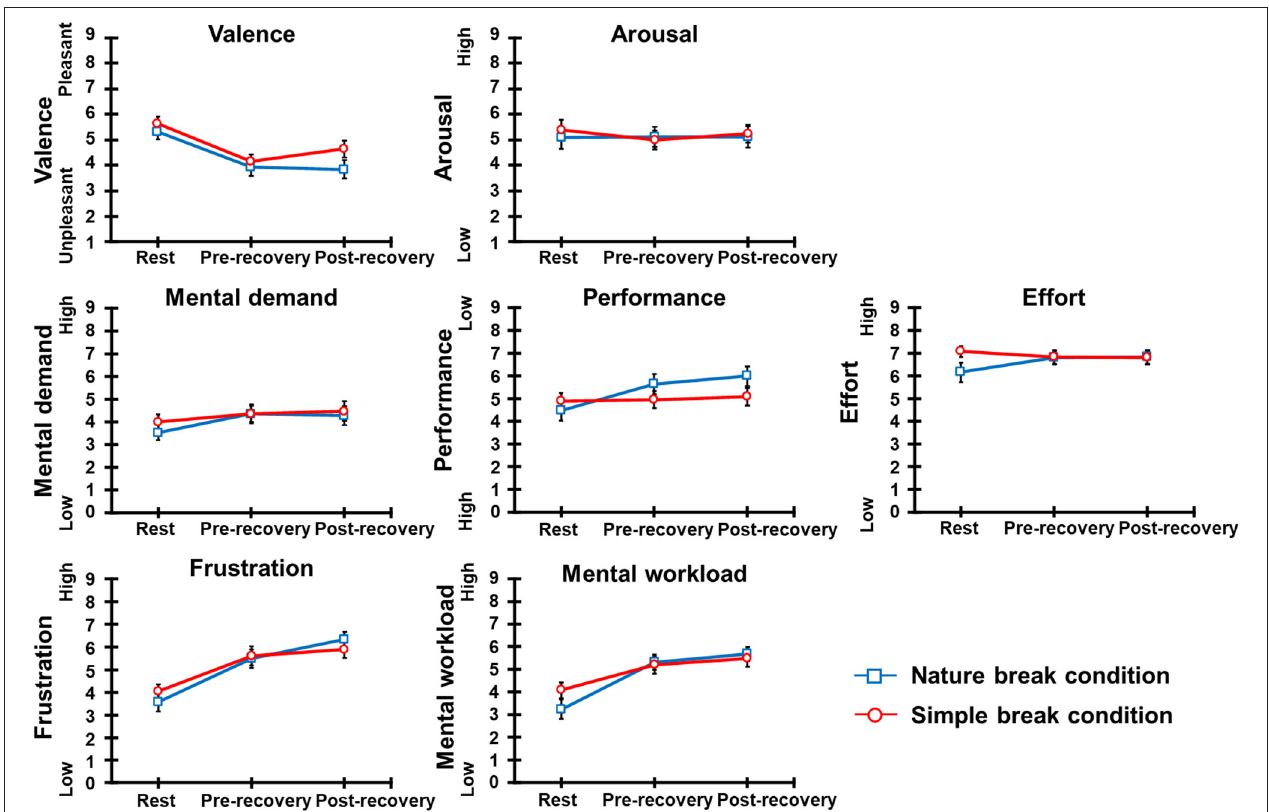
FIGURE 4 | Subjective ratings and standard errors for each simple and nature break